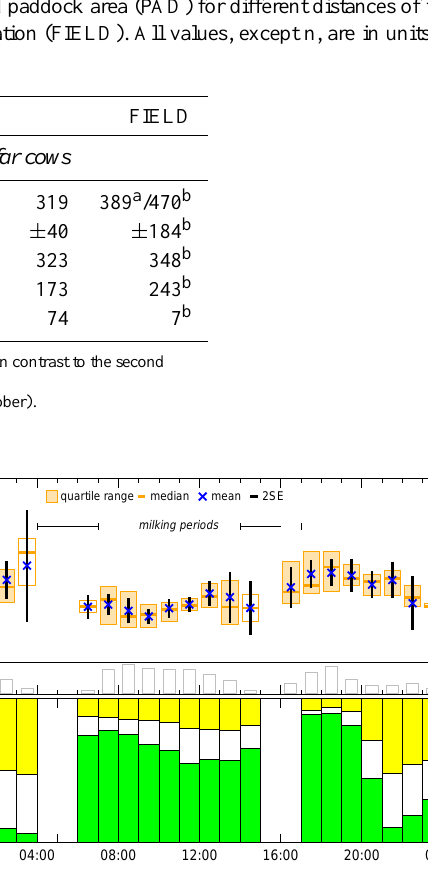
Figure 10. (a) Average diel variation of CH 4 cow emissions (GPS method) for the near cows cases. White quartile range boxes indi- cate hours where less than five values are available. The uncertainty is given as 2SE (black lines). White bars (bottom) show the num- ber of values for each hour (right axis). The two gaps indicate the time when the cows were in the barn for milking. The dashed line in the second milking period indicates that the cows sometimes stayed longer in the barn. (b) Average time cows spent per hour for grazing (green), ruminating (yellow), and idling (white) activity, mean diel cycle for the entire grazing